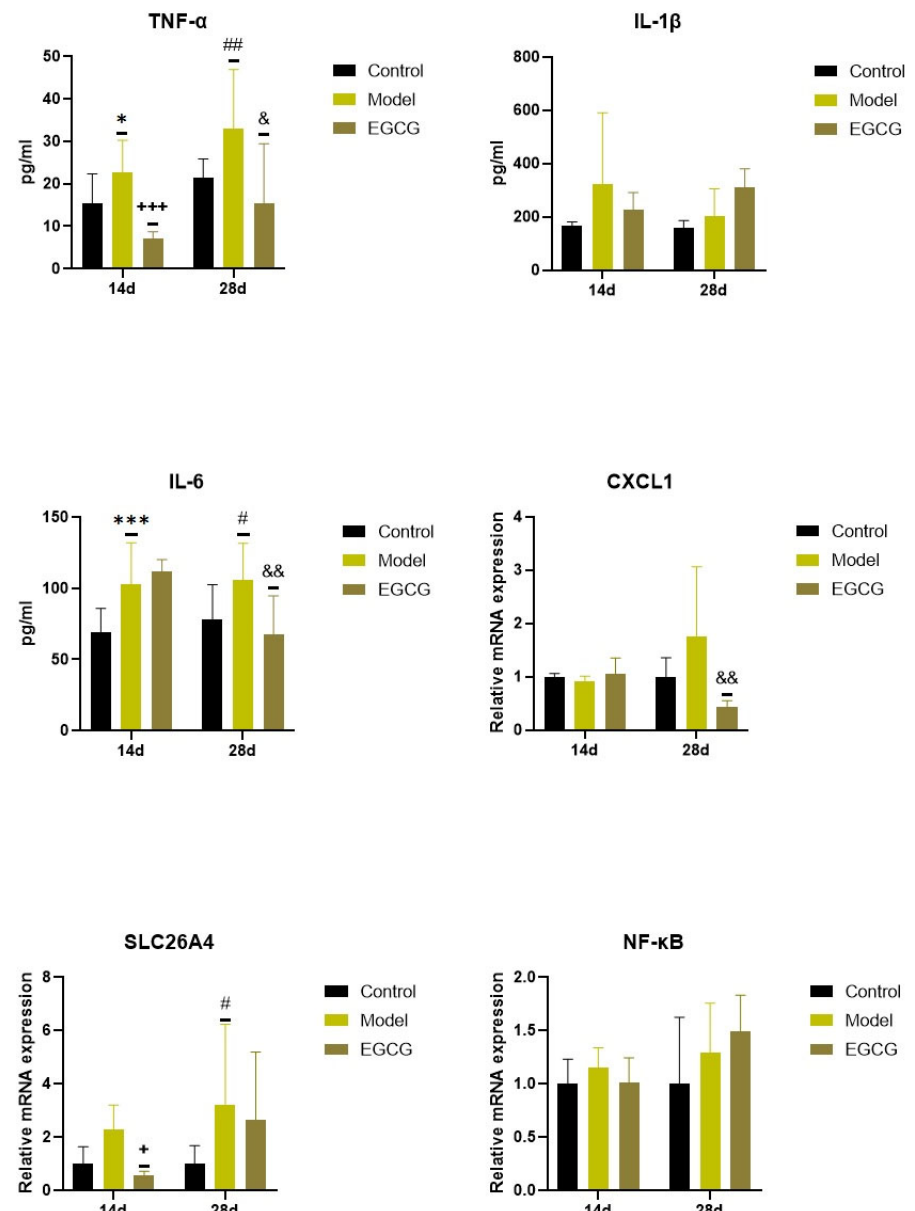
Figure 2. Changes in the inflammatory markers in the lungs of saline-instilled animals (Control), silica-instilled non-treated animals (Model), and EGCG-treated silica-instilled animals (EGCG) after 14 days (14d) or 28 days (28d) of the treatment delivery. Abbreviations: TNF α : tumor necrosis factor alpha; IL-1 β : interleukin-1beta; IL-6: interleukin-6; CXCL1: chemokine (C-X-C motif) ligand 1; SLC26A4: solute carrier family 26, member 4; NF- κ B: nuclear factor-kappa B. For statistical differences among the groups: * p < 0.05 and *** p < 0.001 for Model14d vs. Control14d; + p < 0.05 and +++ p < 0.001 for EGCG14d vs. Model14d; # p < 0.05 and ## p < 0.01 for Model28d vs. Control28d; & p < 0.05 and && p < 0.01 for EGCG28d vs. Model28d. Increases in two additional inflammatory markers, chemokine (C-X-C motif) ligand 1 (CXCL1) and solute carrier family 26, member 4 (SLC26A4), were found in the silica-instilled animals compared to controls after 28 days ( p > 0.05 for CXCL1, p < 0.05 for SLC26A4) (Figure 2). Treatment with EGCG decreased lung concentrations of TNF α ( p < 0.001 after 14 days, p < 0.05 after 28 days), IL-6 ( p < 0.01 after 28 days), and CXCL1 ( p < 0.01 after 28 days), but showed no decrease in other markers (IL-1 β , SLC26A4, NF- κ B) (Figure